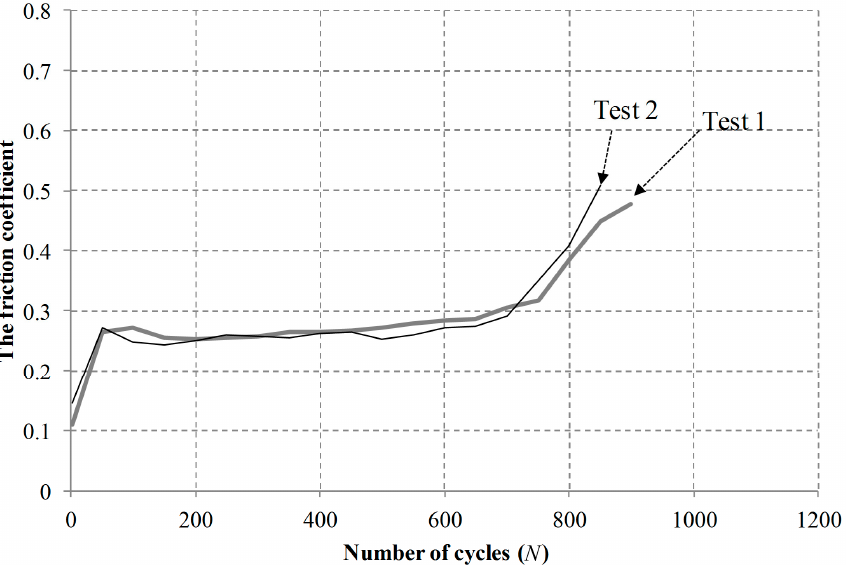
Figure 5. Measured friction coefficient evolutions at a normal force of 50 N, an imposed displacement of 1 mm, and a frequency of 1 Hz.